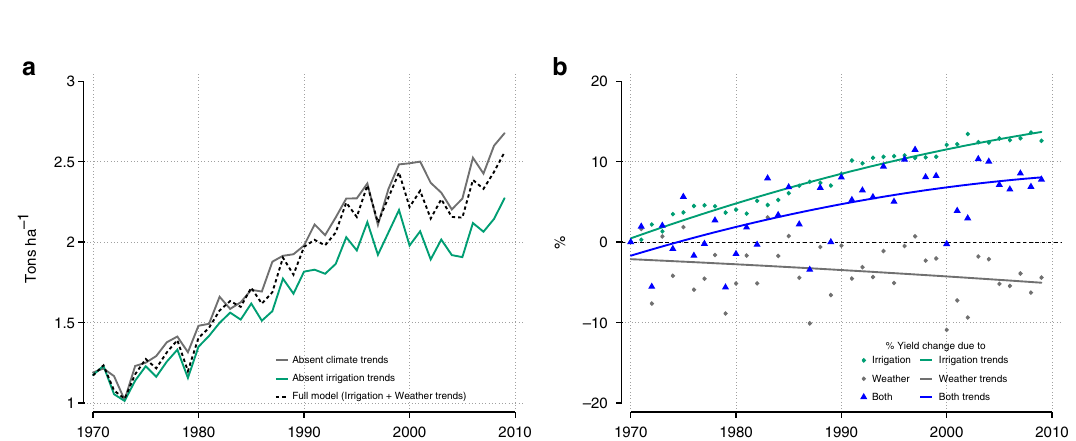
Fig. 2 Breakdown of impacts of irrigation and weather on wheat yields over time. Full model in panel a corresponds to predicted yields using the regression model in column 5, Table 1. The three lines in panel b represent the percent of yield that is lost or gained when comparing predicted yields generated from the Full Model to predicted yields generated when (i) Irrigation is kept at average 1970 – 71 values (green line) (ii) All weather variables are kept at average 1970 – 71 values (gray line) and (iii) Irrigation as well as weather variables are kept at average 1970 – 71 values (blue line). Source data are provided as